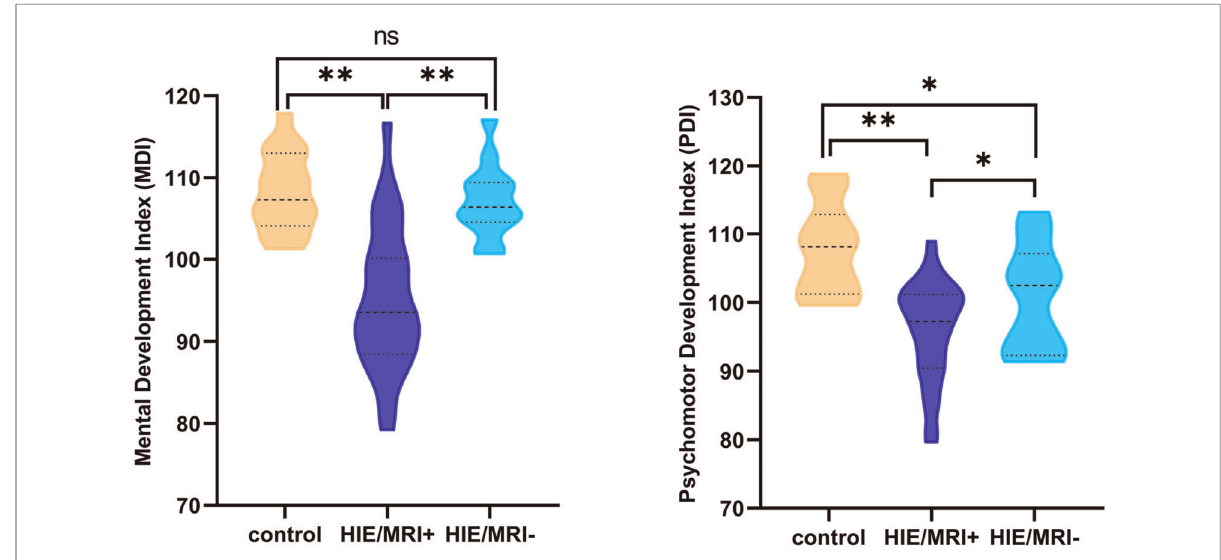
FIGURE 2 Comparison of MDI and PDI scores in the three groups. A single asterisk indicates p <0.05; double asterisks, p <0.001; ns, no signi fi